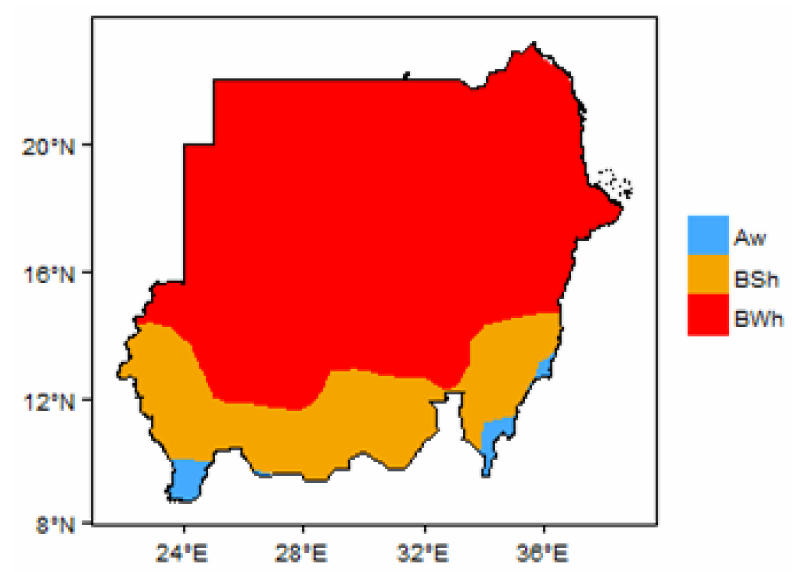
Figure 1. Köppen–Geiger climate classification map of Sudan [2].